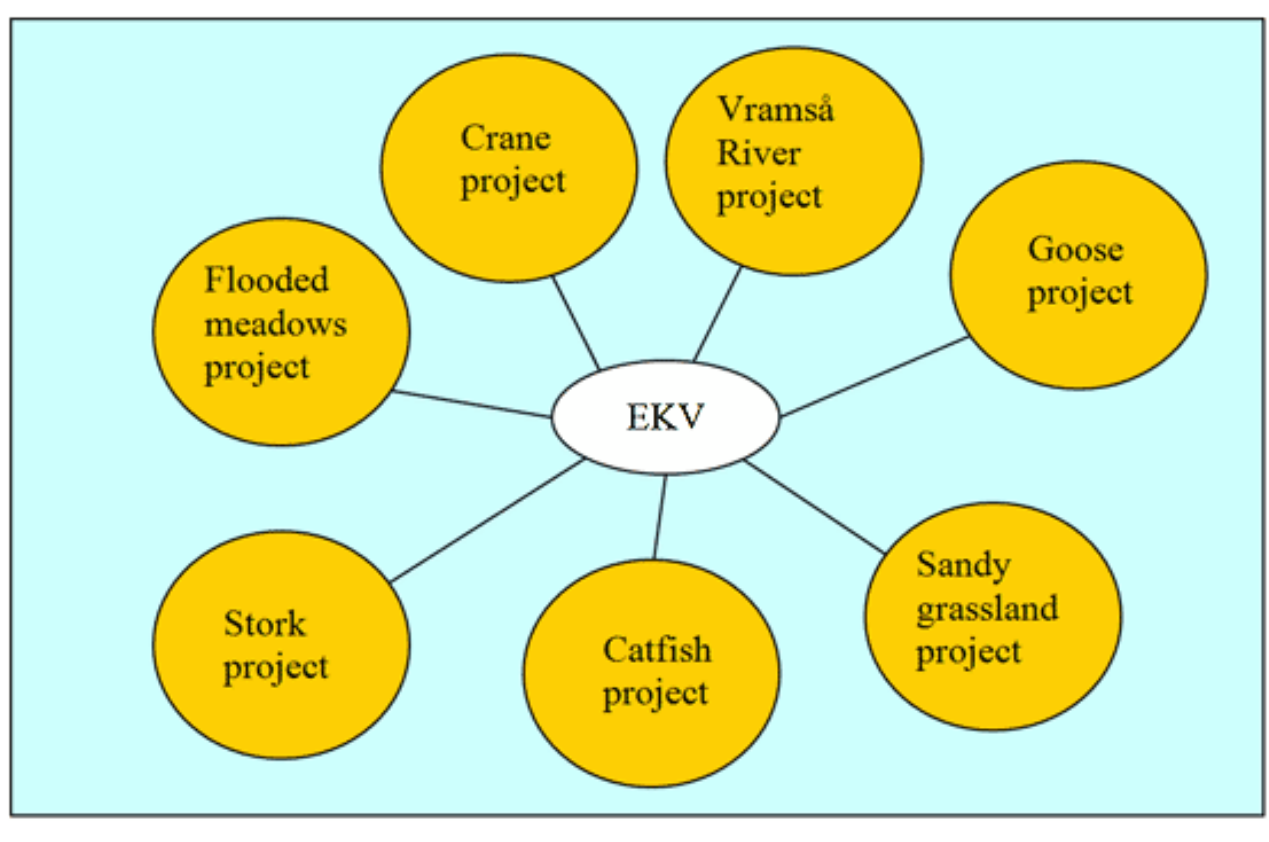
Fig. 6 . The framework for the nature conservation section of Ecomuseum Kristianstads Vattenrike